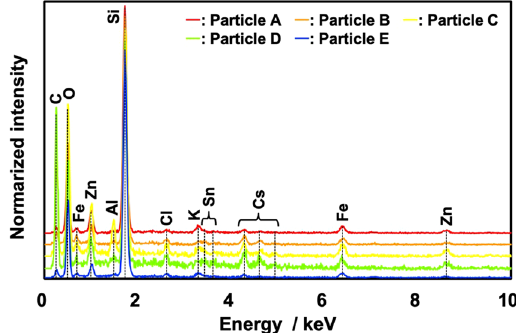
Figure 2. EDS spectra of the five CsMPs.